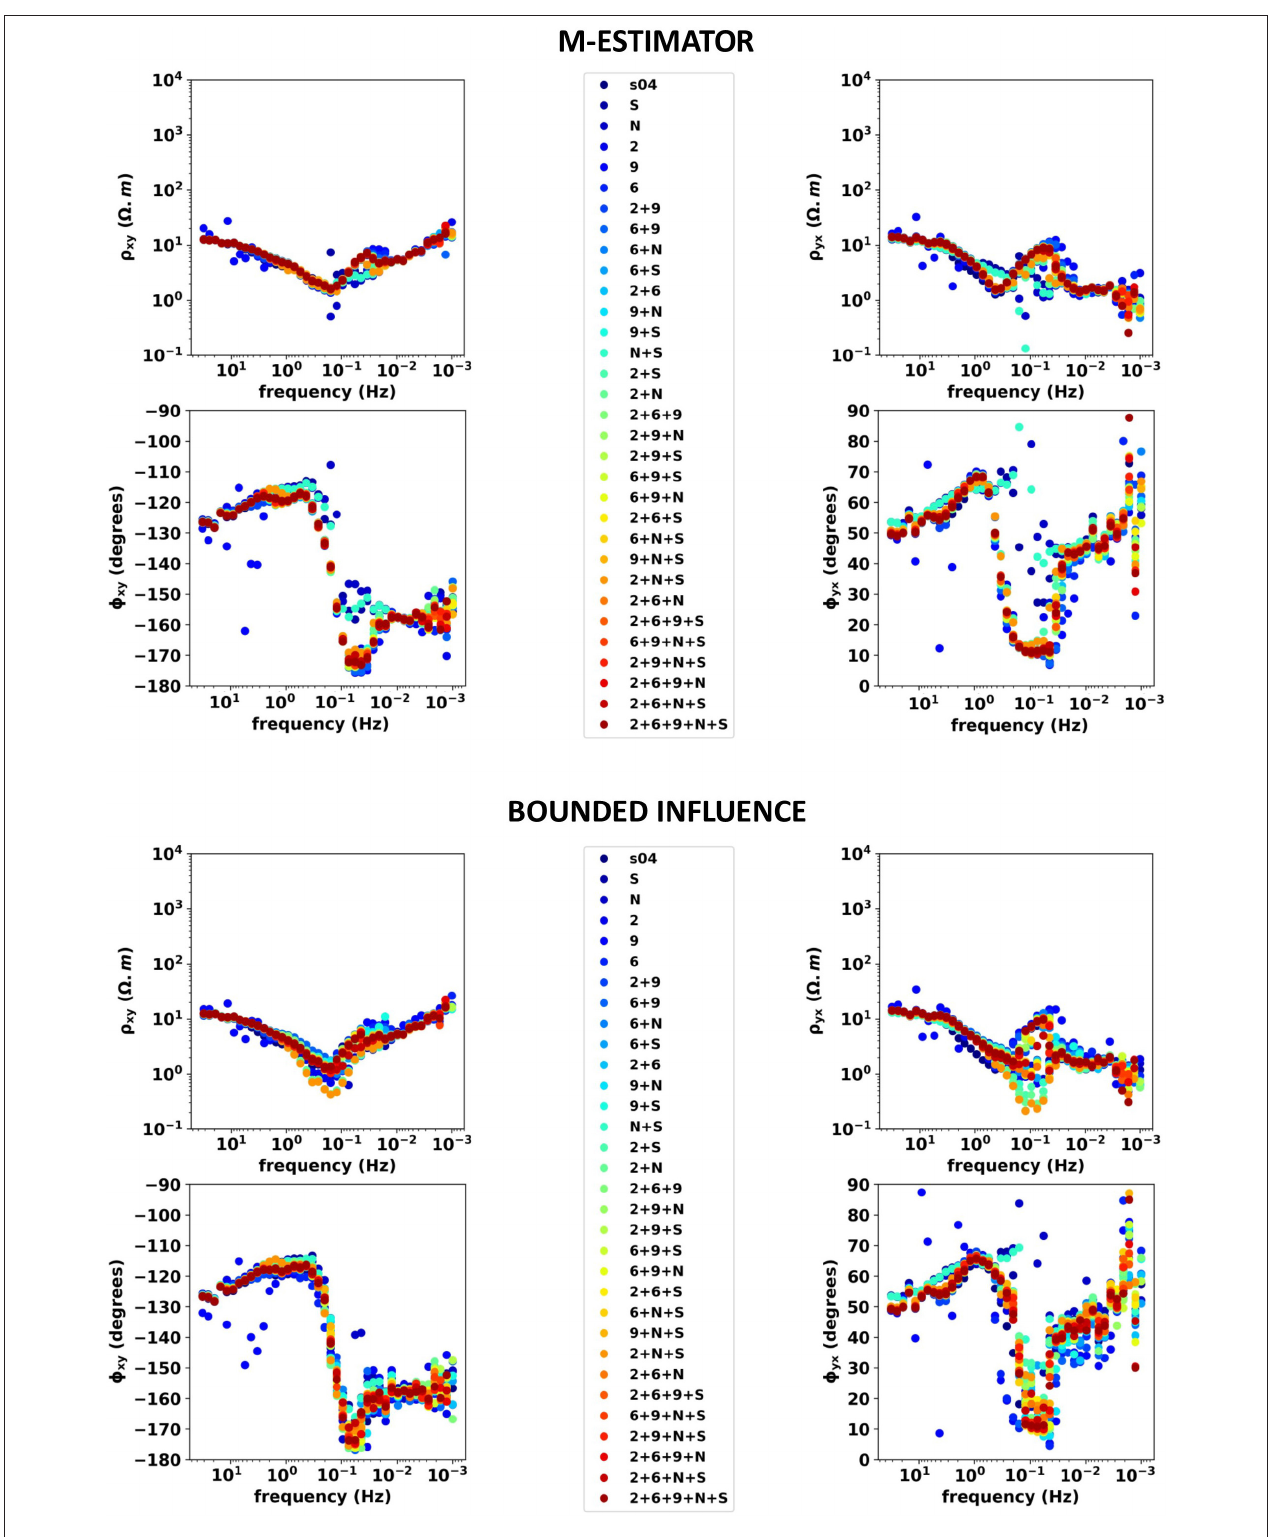
FIGURE 7 | Upper section: M-estimator results. SITE 04 with local RRs 2, 6, and 9 and distant RRs Welschbruch (RR100) and Schwabwiller (R99). No error bars. TF estimates for all possible combinations of RR stations. Apparent resistivity curves ρ xy (top left) and ρ yx (top right) and phases φ xy (bottom left) and φ yx (bottom right) are shown in dots, with a color code corresponding to the associated combination of RR stations(the associated legend is displayed on the center). Lower section: bounded Influence results. Same legend as above.